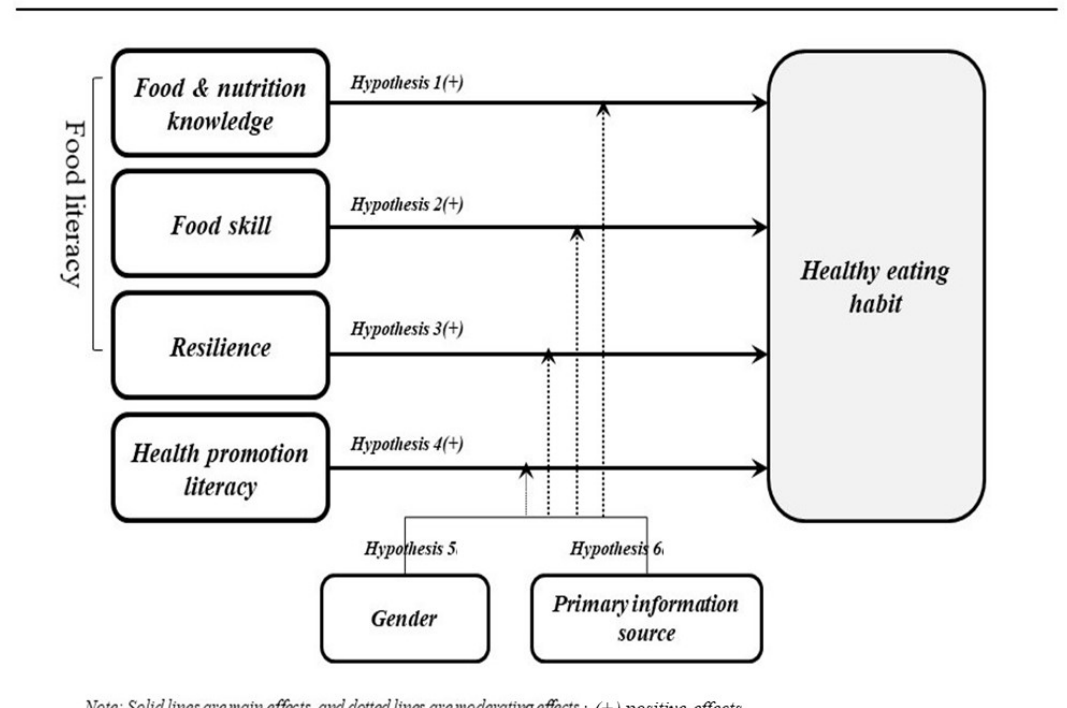
Figure 1. Research